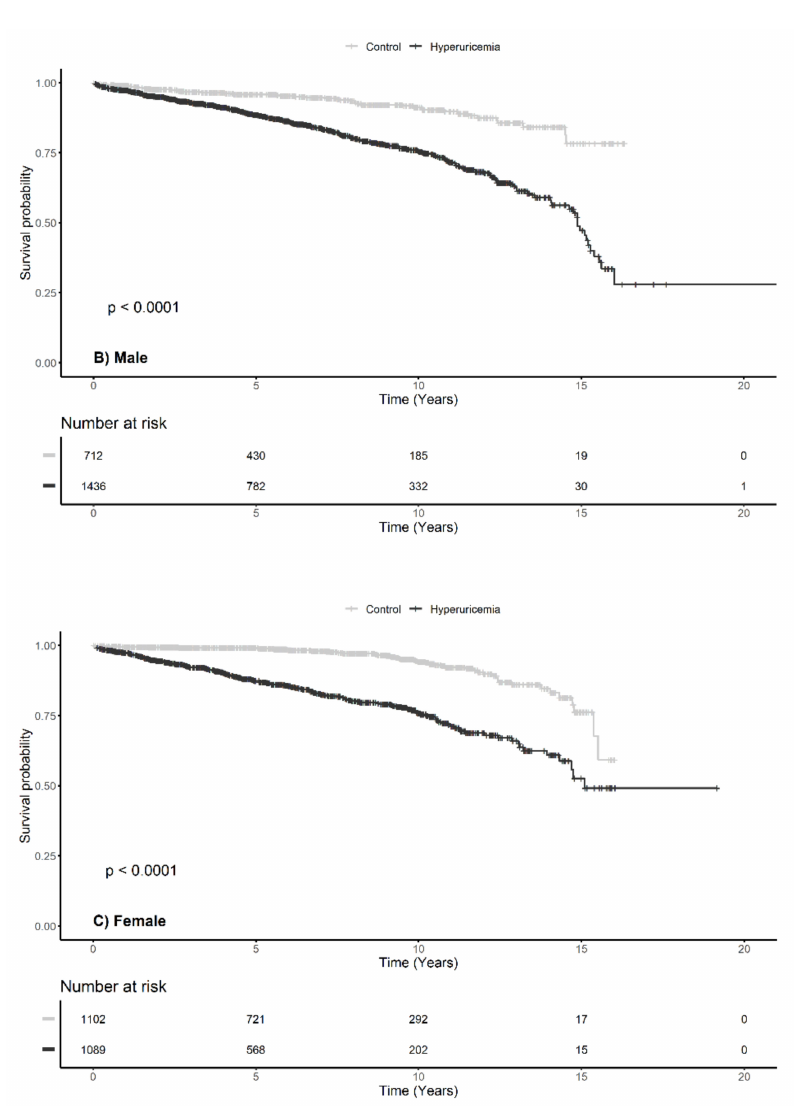
Figure 3. Kaplan—Meier survival curve with log-rank test between major adverse renal event and serum uric acid by